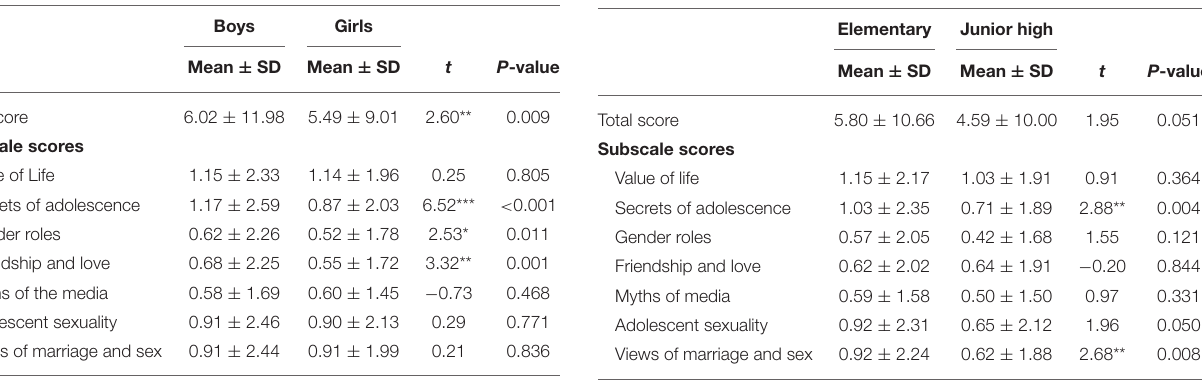
TABLE 2 | Amount of improvement between pretest and posttest for total score and subscale scores for boys ( n = 5,402) and girls ( n = 5,104) in grades 5–9 on the PILSEE.